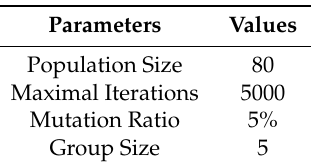
Figure 6. Computing time comparison. Table 3. The GA Parameters for the